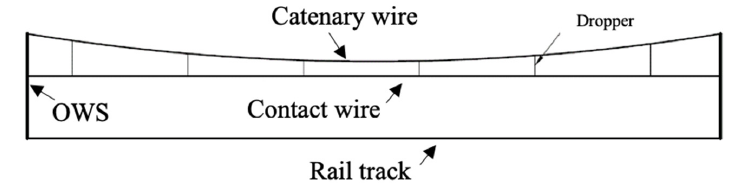
Figure 1. Schematic diagram of rail overhead wiring.